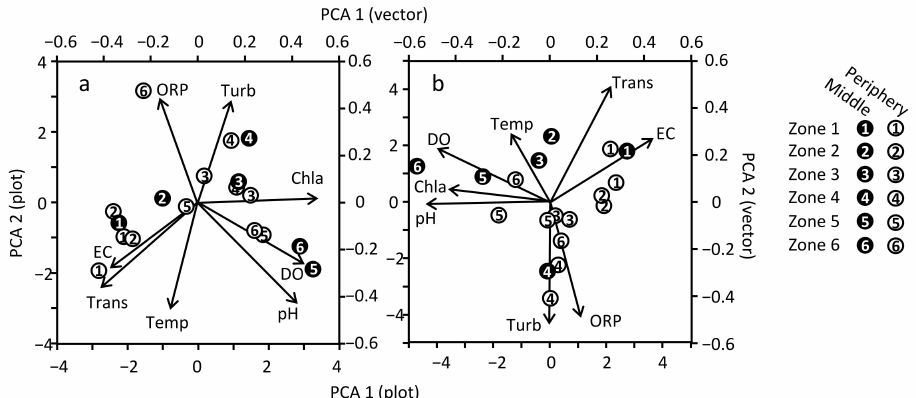
Figure 6. Principal component analysis (PCA) diagram of water quality variables performed among 18 survey sites in MA for each month (( a ): April, ( b ): July, see Figure S3 for other months). The vertical difference (i.e., ∆ layer ) of water temperature was less than 2 ◦ C at most